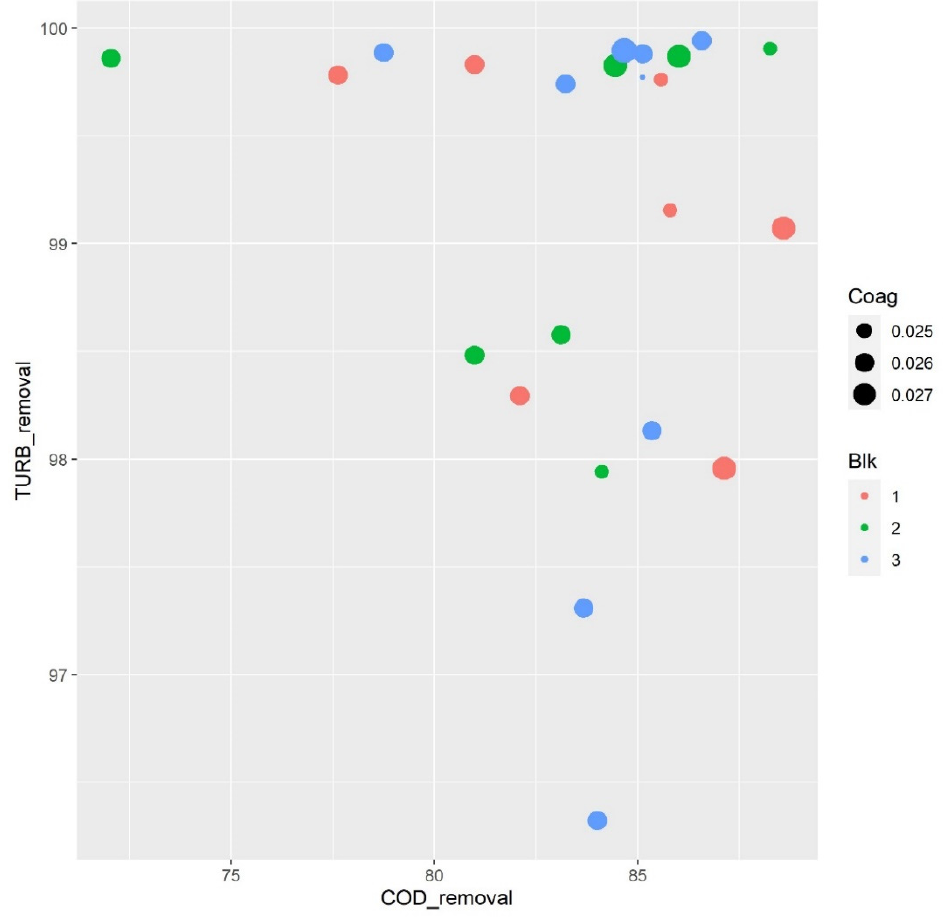
Figure 3. Effect of coagulant concentration on COD and turbidity removal. Coag: coagulation concentration 0.025, 0.026, 0.027 mol L − 1 ); Blk: Blocks number (Blk1, Blk2, Blk3).